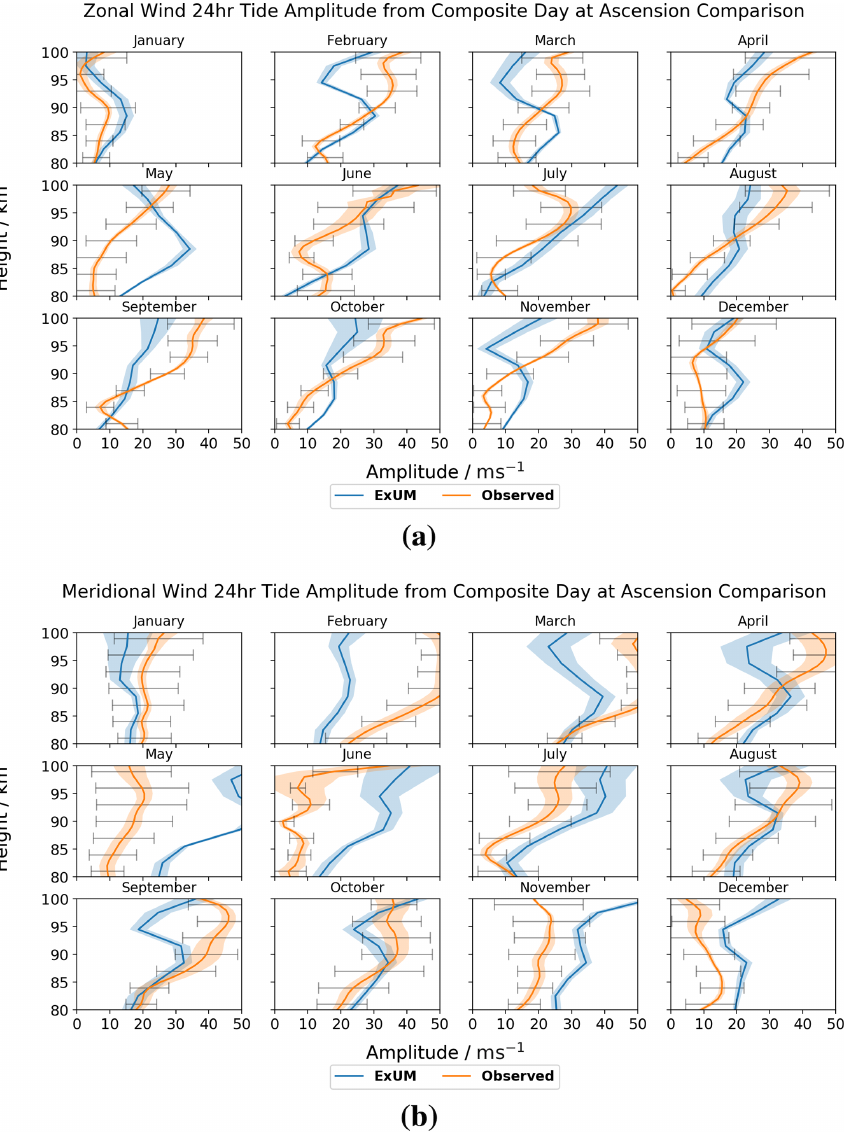
Figure 8. Amplitudes for each month as a function of height for the (a) zonal ( u ) and (b) meridional ( v ) components of the diurnal tide at Ascension Island. The shaded regions denote the standard deviation from the curve-fitting algorithm, and the black bars indicate the standard deviation from the mean of the measured amplitudes across the month. Both the amplitudes from the model (blue) and meteor radar (orange) are